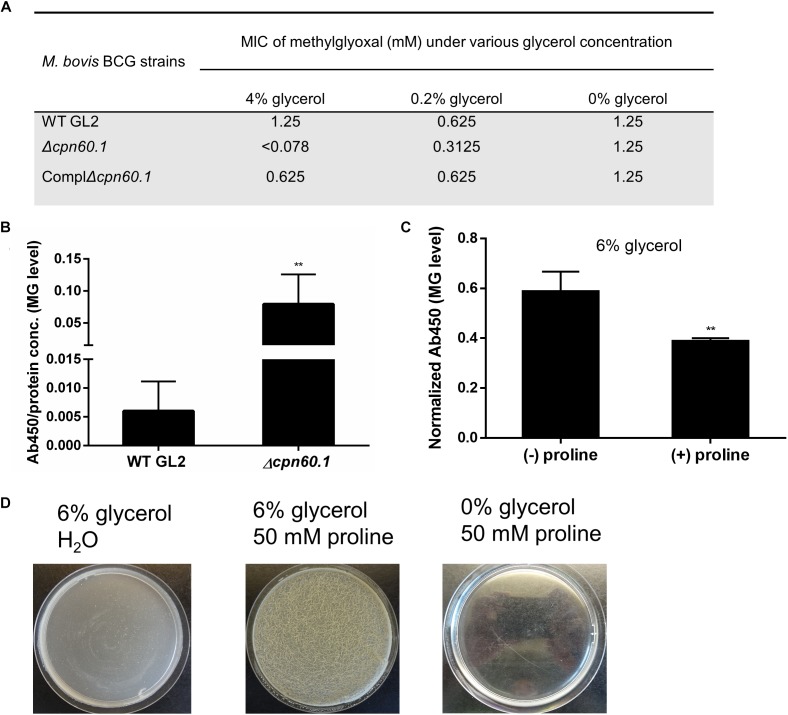
The Δcpn60.1’s accumulation of methylglyoxal and rescue of its biofilm by proline-mediated detoxification. (A) MIC of methylglyoxal determined in 7H9 medium with varying amounts of glycerol. (B) Cellular extracts of BCG grown in 6% glycerol Sauton’s medium were determined for methylglyoxal–protein adducts by ELISA. Absorbance at 450 nm was normalized by dividing by protein concentration. ∗∗p ≤ 0.01 relative to WT by unpaired t-test. (C) WT BCG protein extracts from 6% glycerol Sauton’s medium (±25 mM proline) were quantified for methylglyoxal, followed by data normalization as per protein concentration. ∗∗p ≤ 0.01 by unpaired t-test. (D) The Δcpn60.1 biofilm was grown in 6% glycerol Sauton’s medium for 25 days with or without 50 mM proline. A control with proline and without glycerol was included.